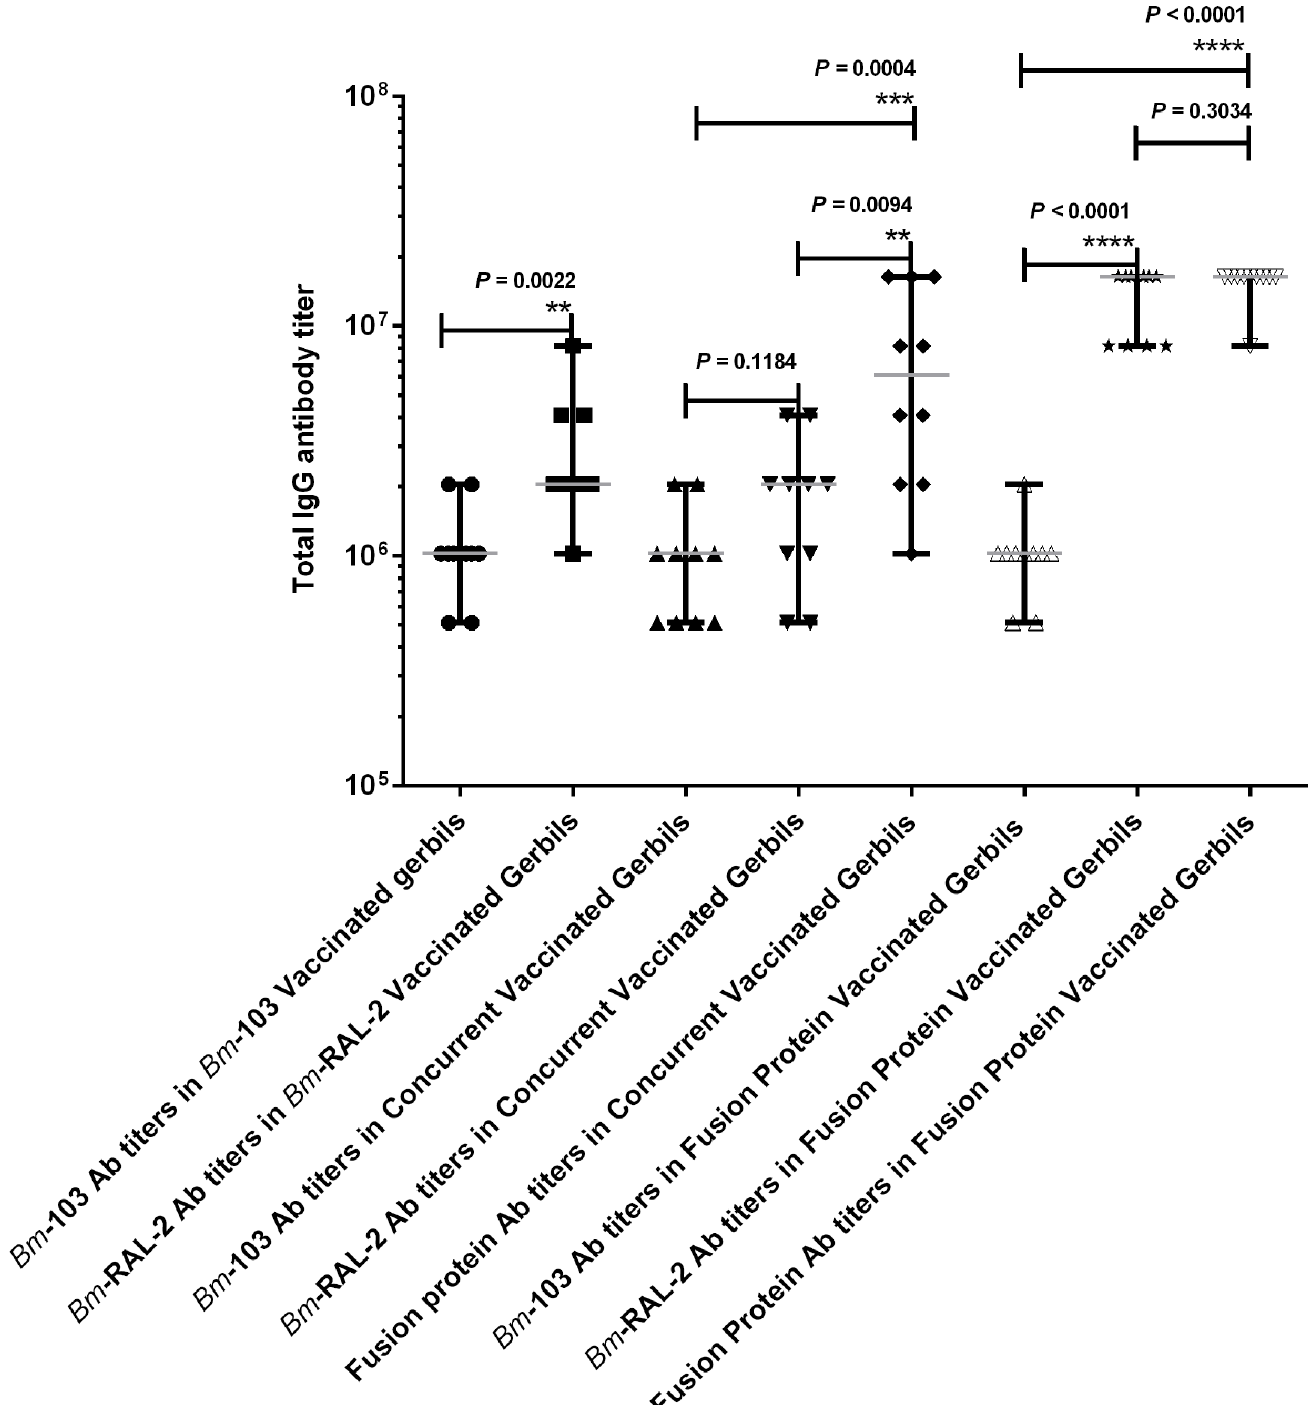
Fig 3. Total IgG endpoint titers specific to Bm -103, Bm -RAL-2 or the fusion protein in gerbils vaccinated (N = 10) with Bm -RAL-2 and Bm -103 individually, concurrently or as a fusion protein. Each dot represents IgG endpoint titer from an individual animal. The lines represent median with maximum and minimum range. Asterisk/s denotes a statistically significant difference in IgG endpoint titers between analyzed groups, Mann – Whitney U Test, GraphPad Prism 6 ( * , P (cid:1) 0.05; ** , P (cid:1) 0.01; *** , P (cid:1) 0.001; **** , P (cid:1) 0.0001).